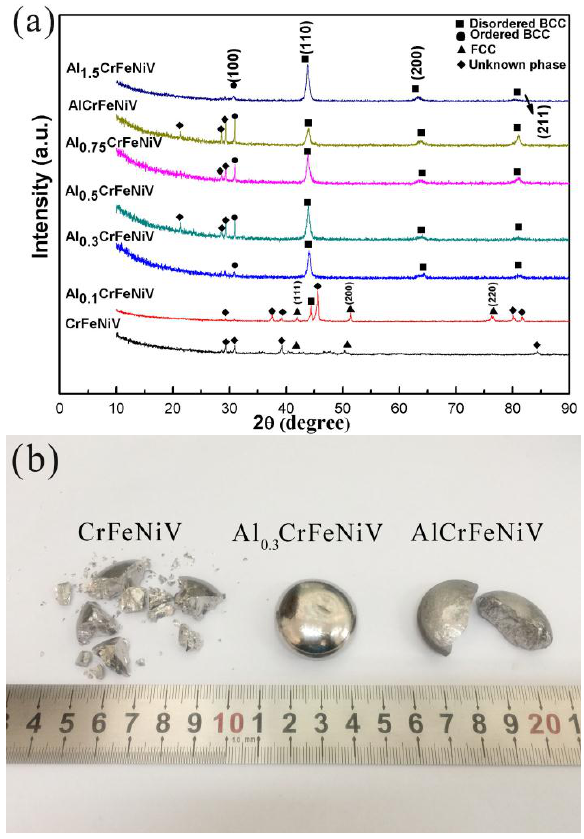
Figure 1. ( a ) XRD patterns of the as-cast Al x CrFeNiV HEAs; ( b ) Macroscopic samples of the three representative alloys CrFeNiV, Al 0.3 CrFeNiV, and AlCrFeNiV.